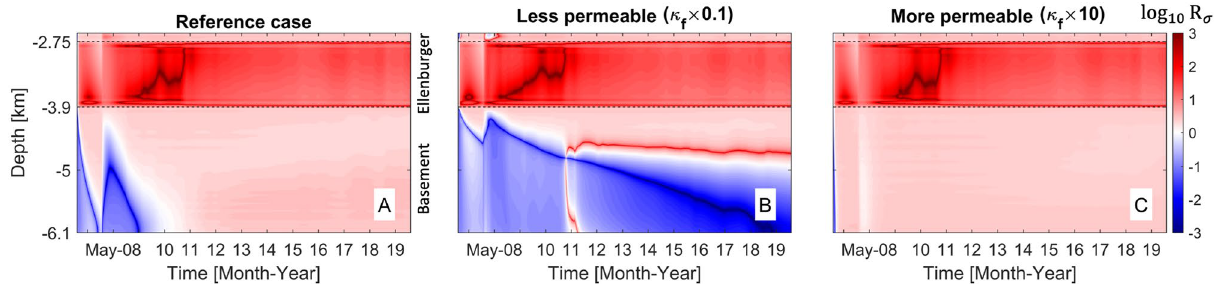
Figure 5. Spatio-temporal distribution of log 10 R σ along the fault line for variation in WVF permeability: ( A ) reference case ( κ f permeable fault ( κ f